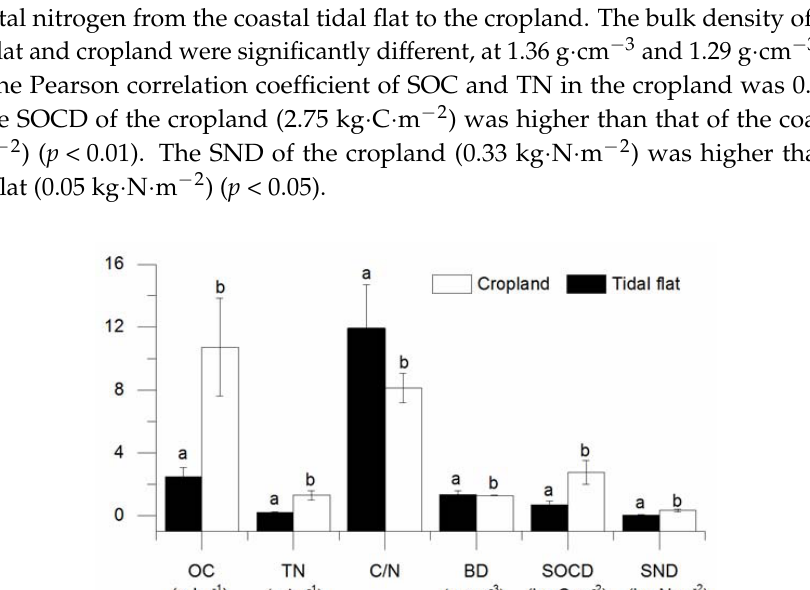
Figure 2. Soil organic carbon (SOC), total nitrogen (TN), C/N, bulk density (BD), soil organic carbon density (SOCD), and soil nitrogen density (SND) of the coastal tidal flat and cropland. Vertical bars denote standard errors of means. Bars with the different letters indicate significant differences at p < 0.05.